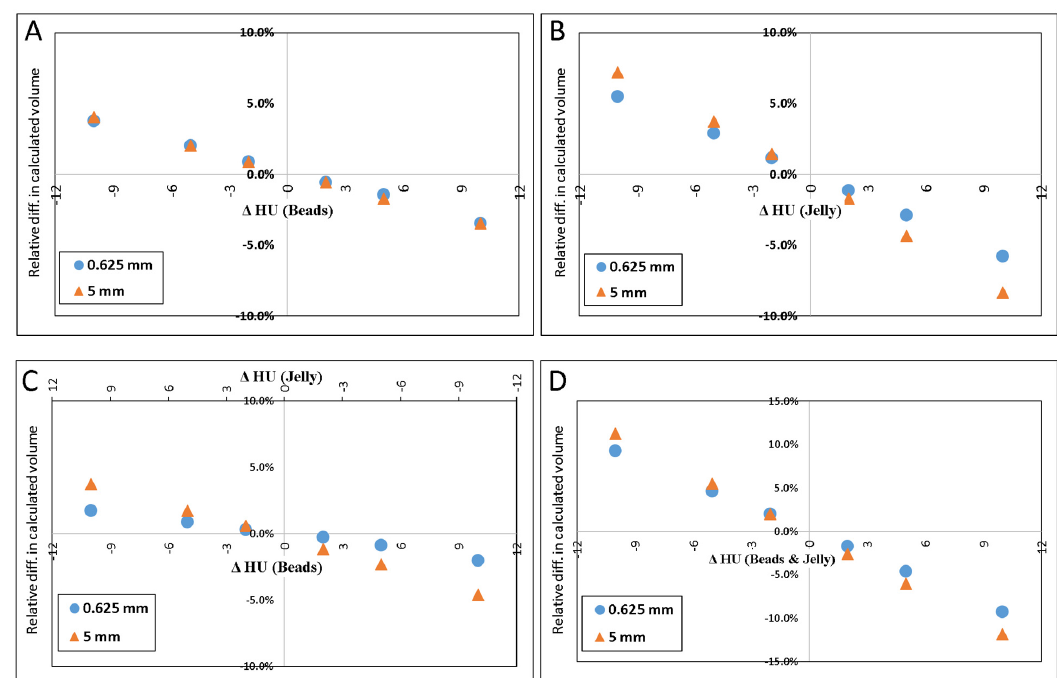
Figure 4. Scatter plot of the difference in calculated volume when HU of petroleum jelly or PMMA beads was changed. Δ HU indicates the difference in the HU. Scatter plot ( A ) shows the effect (in percent) of calculated volume when only HU bead was changed. ( B ) shows the result when only the HU jel was changed. In ( C ), the plot demonstrates the result when either one was changed by one sign (+/ − ), and the other was changed by the opposite sign. When both materials’ HU were changed by the same sign the resulted effect on the calculated volume is shown in ( D ).